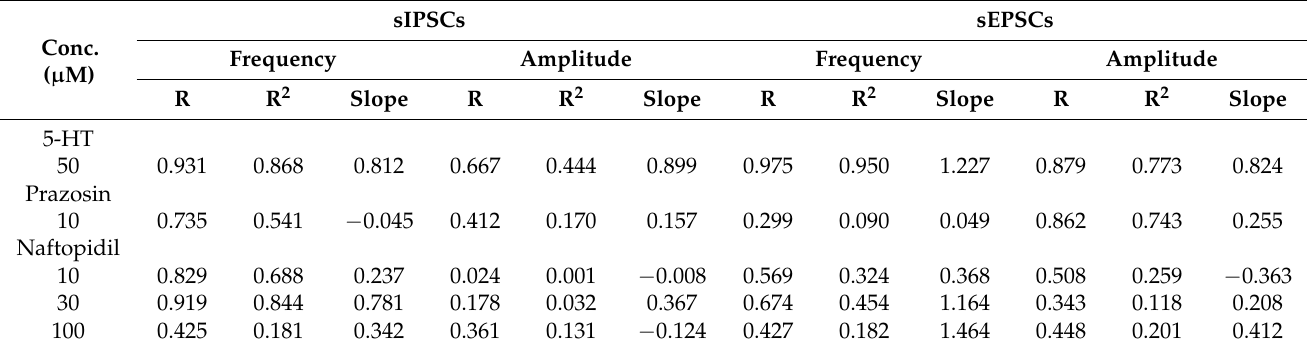
Table 1. Correlation of sIPSCs and sEPSCs with noradrenalin.